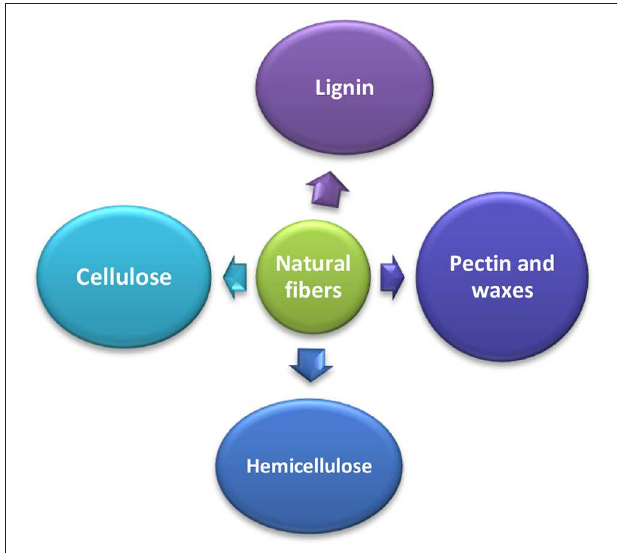
FIGURE 1 | Constituents of plant fibers (Faruk et al.,